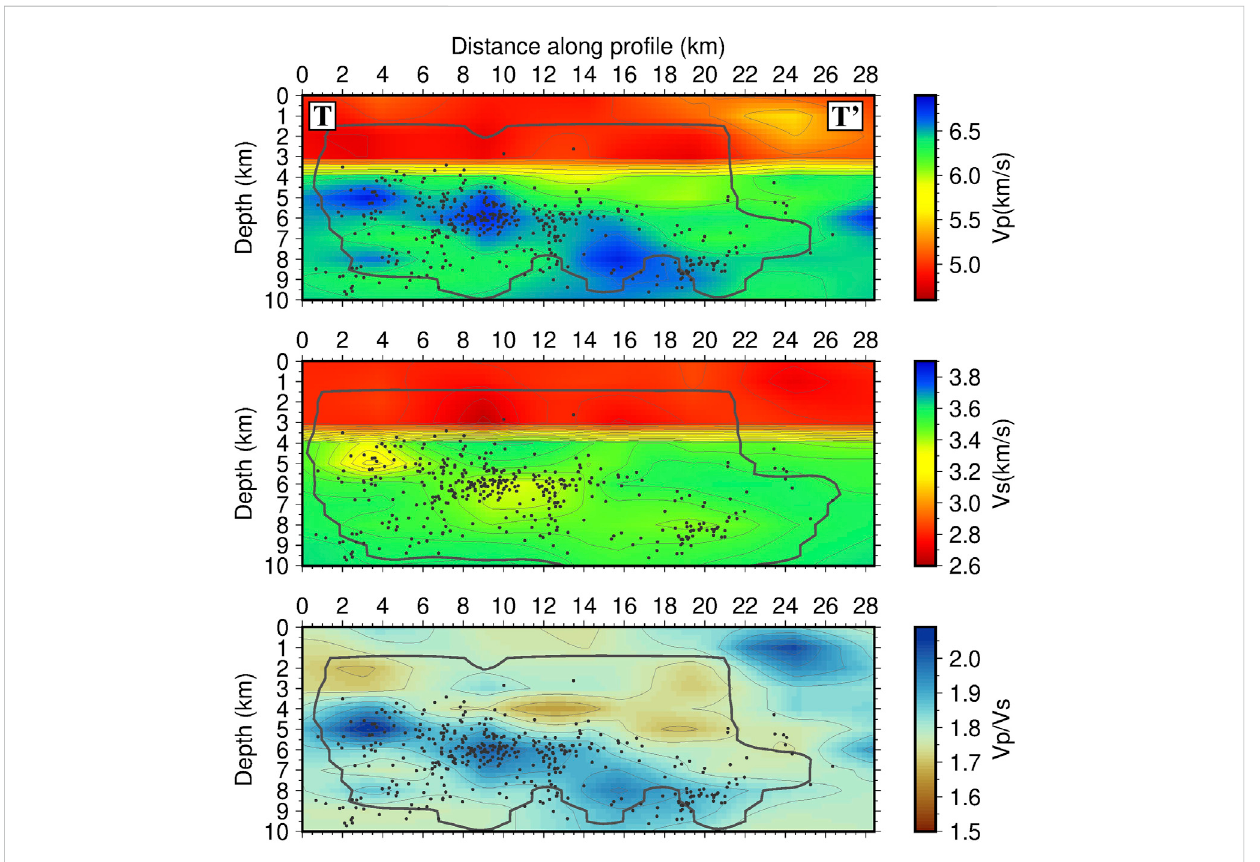
FIGURE 4 V P ,V S andV P /V S modelandmicro-earthquakelocationsprojectedontotheTT ’ cross-sectionlocatedinFigure1.Well-resolvedareasarecontoured by solid dark gray lines. Earthquakes within 1 km from each side of the slice are shown with black